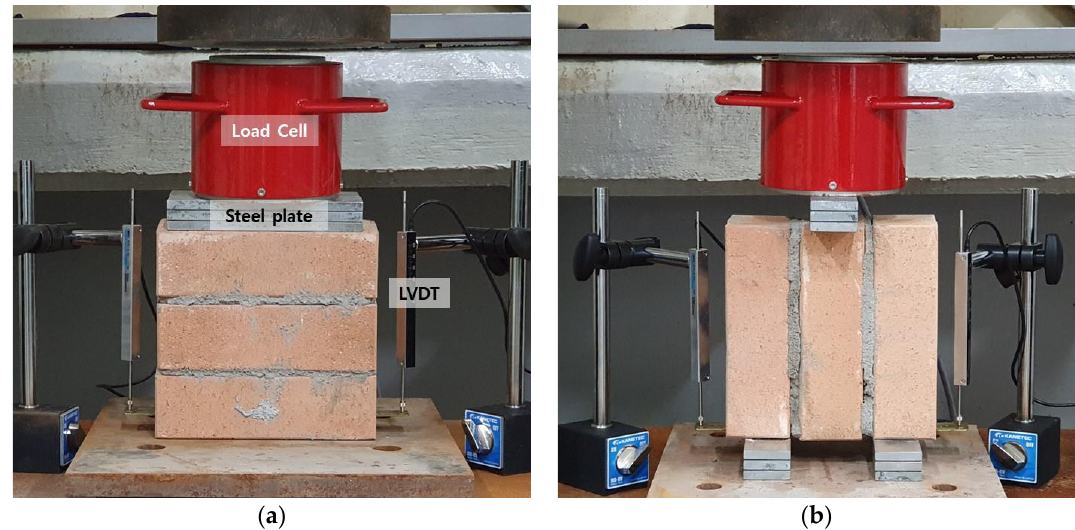
Figure 3. Test setup for compressive strength and initial shear strength: ( a ) Compressive strength test of specimen CR; ( b ) Initial shear strength test of specimen SR.